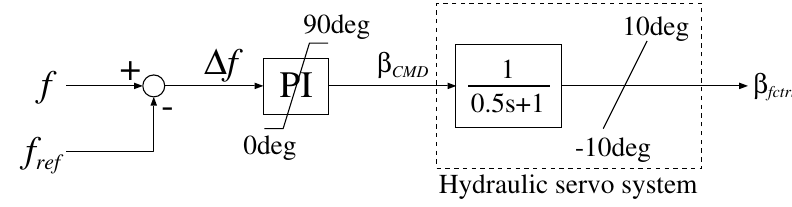
Figure 8. Pitch angle control system.